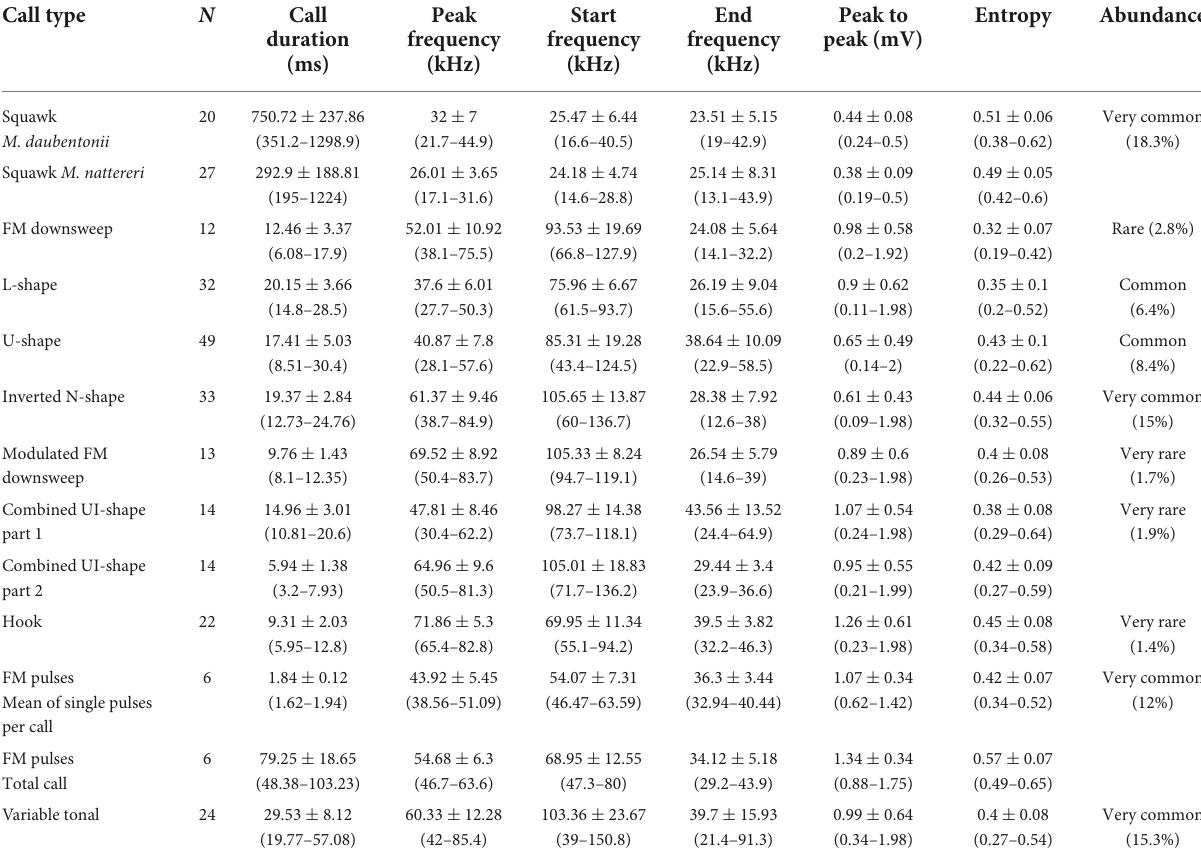
TABLE 1 Mean and standard deviation of social call parameters per call type (range is given in parentheses).